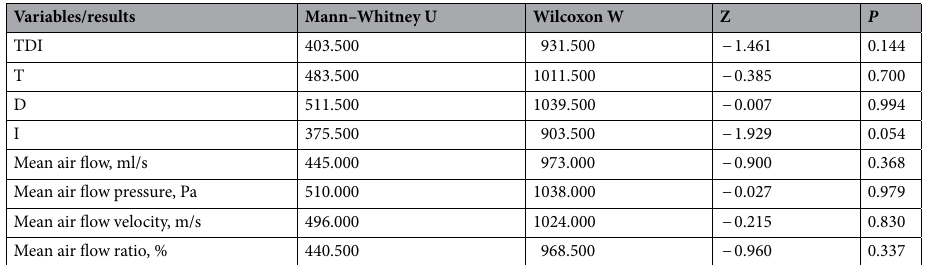
Table 1. The variance analysis of variables on both sides of subjects. The mean air flow, the average volume of air flow passing through a certain position of the nasal cavity; the mean air flow pressure, the average pressure of air flow passing through a certain position of the nasal cavity; the mean air flow velocity, the average velocity of air flow passing through a certain position of the nasal cavity; the mean air flow ratio, the mean ratio of the air flow through a certain section of the nasal olfactory cleft to the total air flow through the nasal